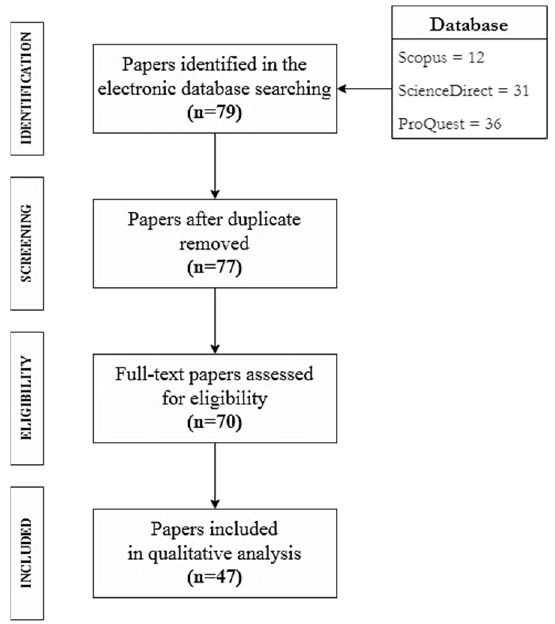
Figure 1. PRISMA framework.